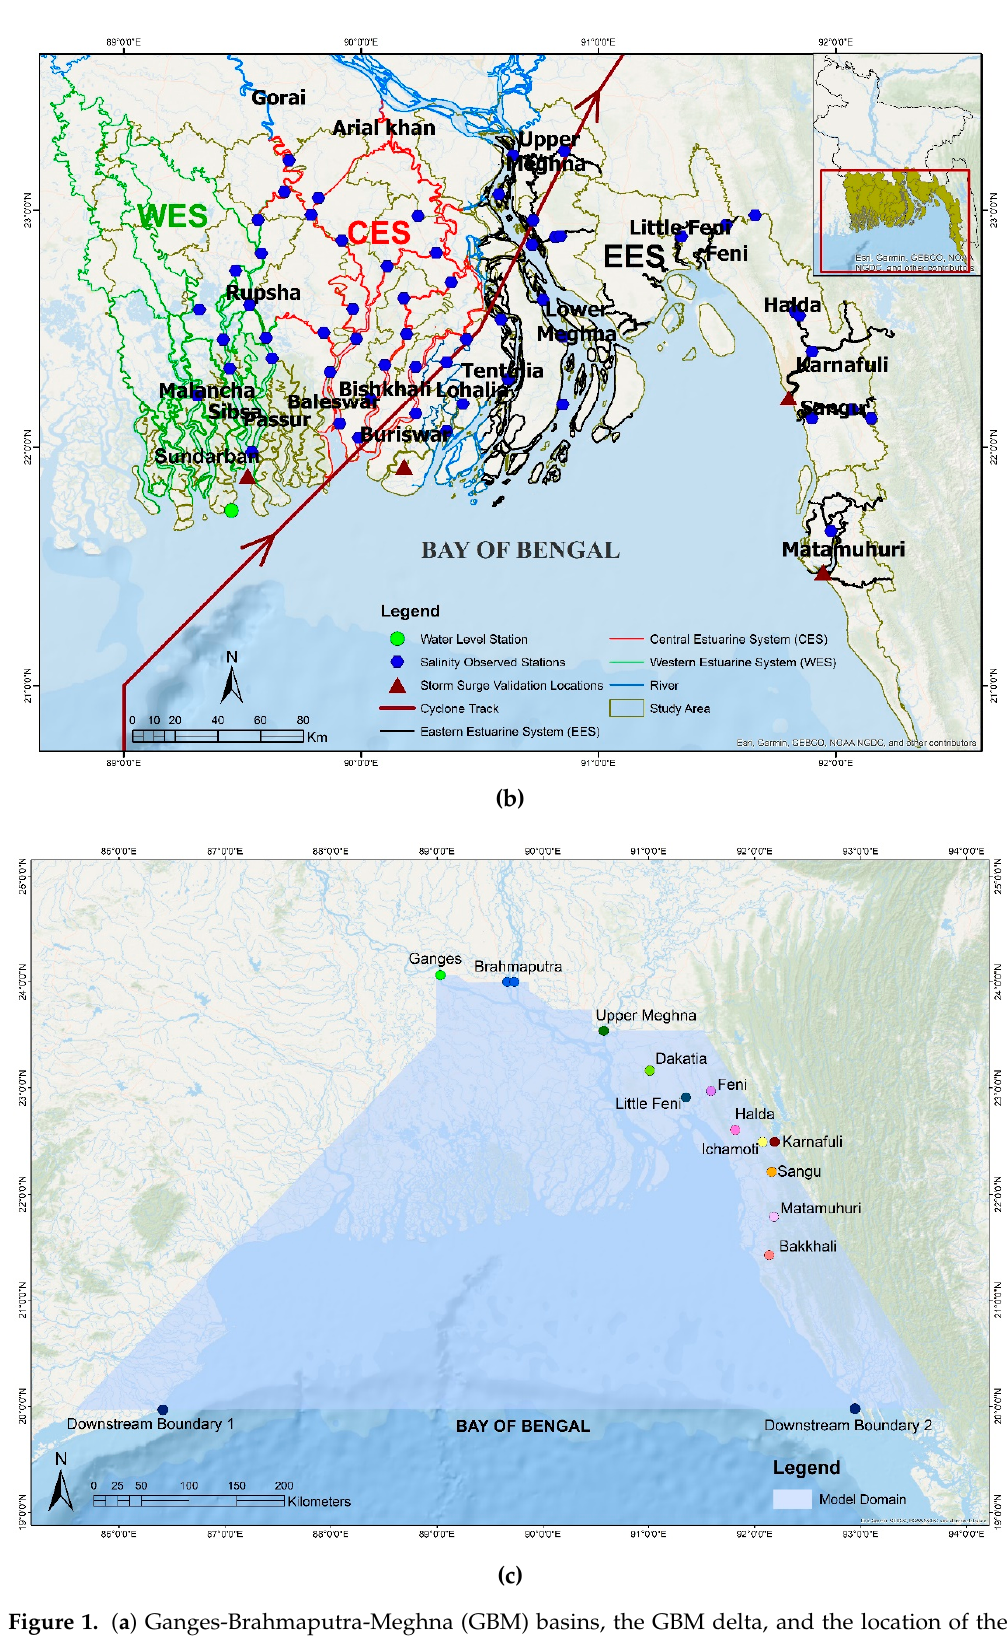
Figure 1. ( a ) Ganges-Brahmaputra-Meghna (GBM) basins, the GBM delta, and the location of the Farakka barrage. ( b ) The study area with observed stations and calibration / validation locations. ( c ) The upstream and downstream boundaries of the model